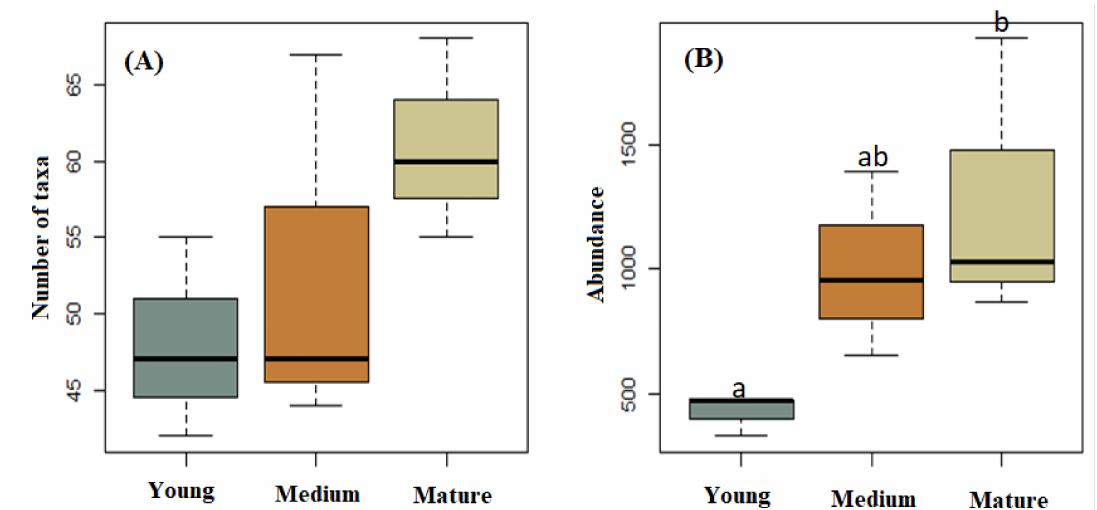
Figure 2. Number of taxa ( A ) and total abundance ( B ) of macrofungal species collected from young, medium-aged, and mature Pinus radiata stands in Menagesha Suba, central Showa, Oromia National Regional State, Ethiopia. Boxplot data showing the max and min values. The bar in the box is the standard deviation of the mean. Values with the same letter are not significantly different.